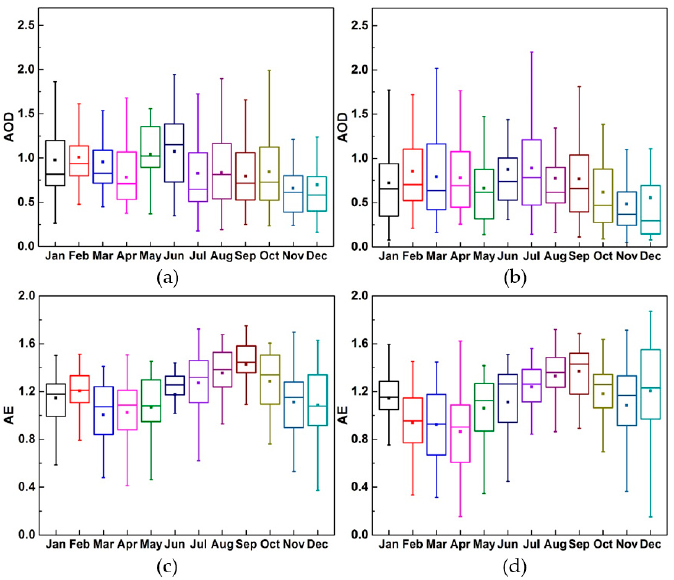
Figure 9. Monthly variations of AOD at ( a ) Wuhan and ( b ) Dengfeng; monthly variations of AE at ( c ) Wuhan and ( d ) Dengfeng.